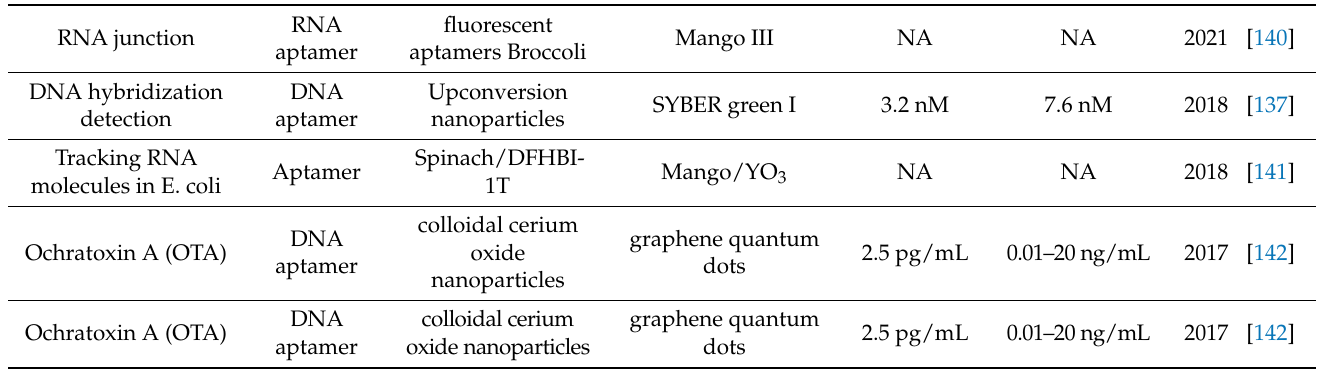
Table 3. FRET-based aptamer sensor showing donor, acceptor, LOD, CR, and year-wise advancement in